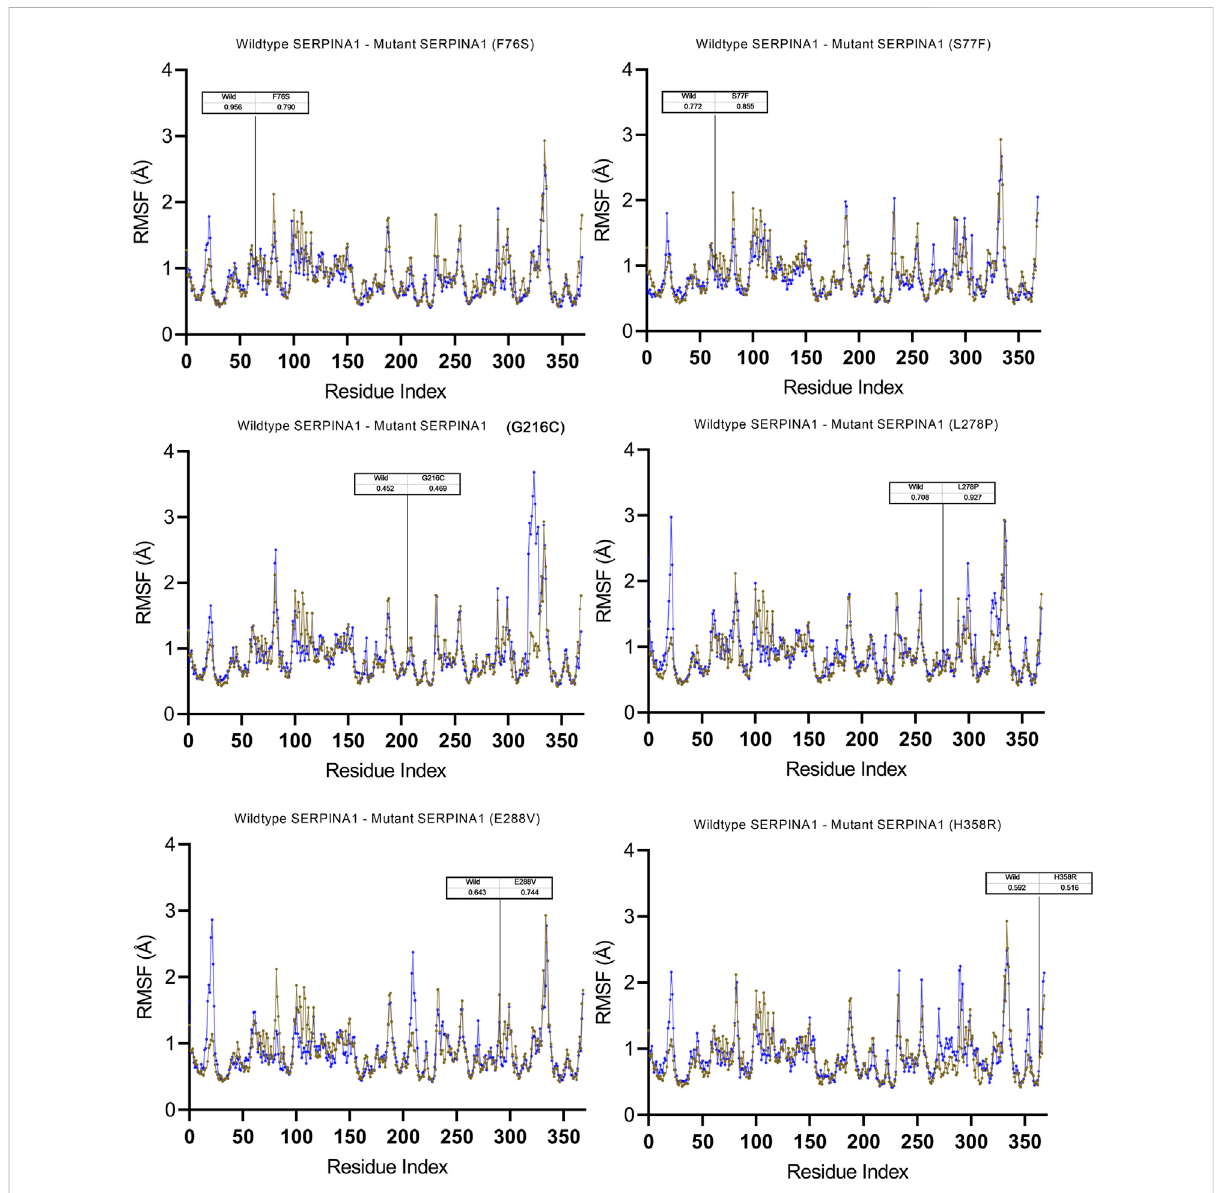
FIGURE 5 Moleculardynamicssimulationmeasuring fl uctuationinstructuralstabilityattheaminoacidlevelfor6A1ATvariants(F76S,S77F,G216C,L278P, E288V, and H358R) after being subjected to a